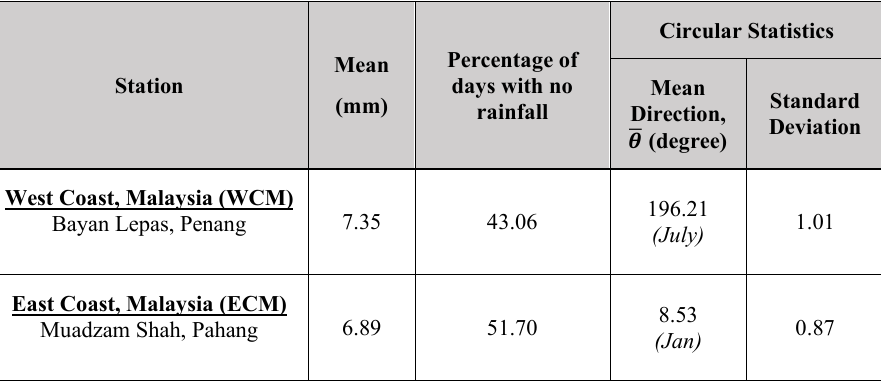
Circular Statistics Percentage of Mean days with no Mean Standard (mm) rainfall Direction, Deviation 𝜽̅ (degree)